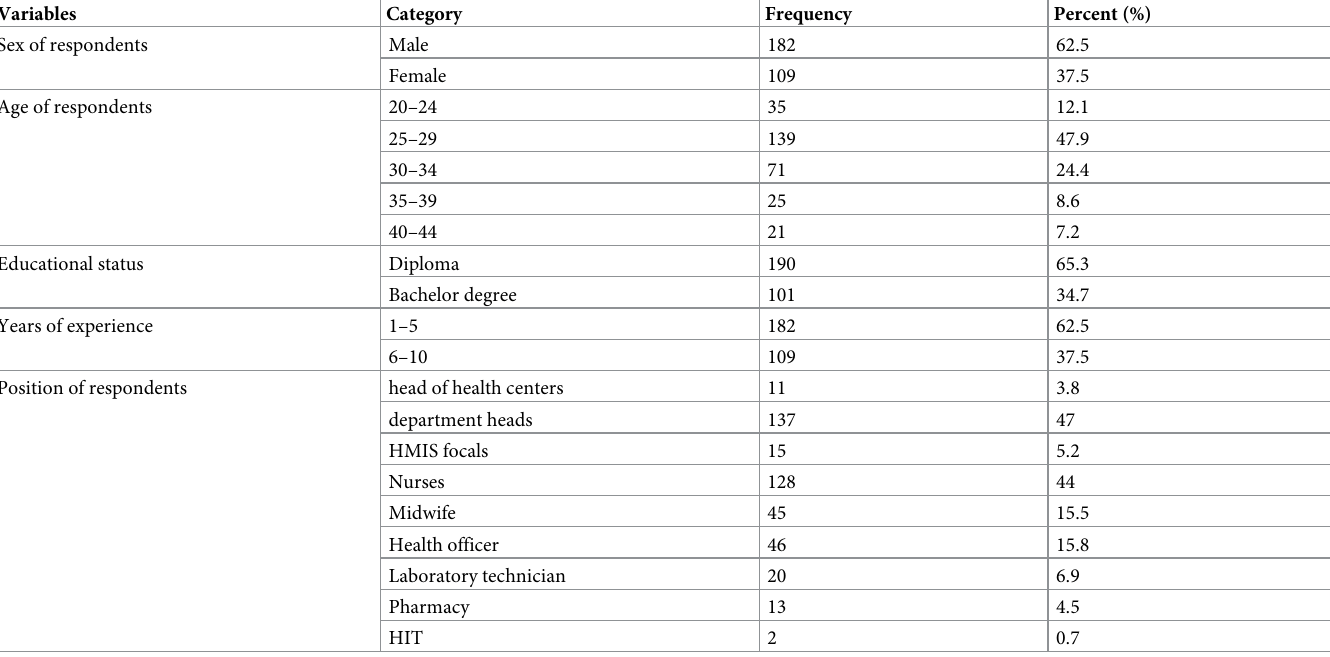
Table 1. Socio demographic characteristics of respondents in health centers of Hadiya zone, Southern Ethiopia, 2018 [n = 291].